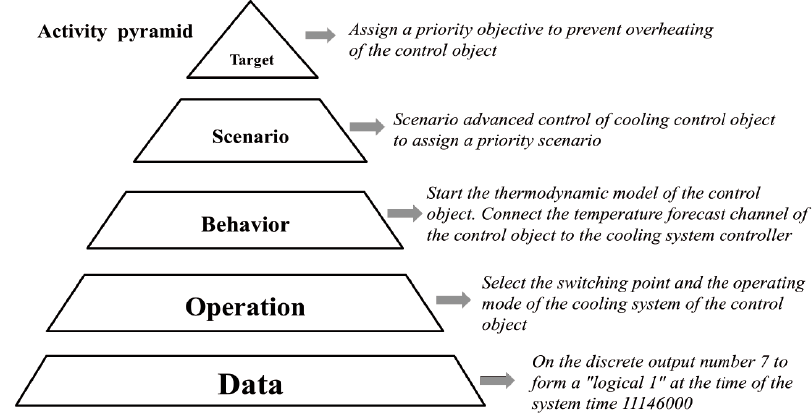
Fig. 3. Elements of a cognitive cooling control systembased on activity